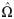
Schematic representation of the global order parameter.The scalar part Q(2) measures the degree of MT order. The vector part Ω^ measures the orientation of the associated MT array and is perpendicular to the plane of the MT array (magenta arrow). The dot (a filled magenta circle) at the tip of Ω^ provides a concise representation of the MT array orientation.